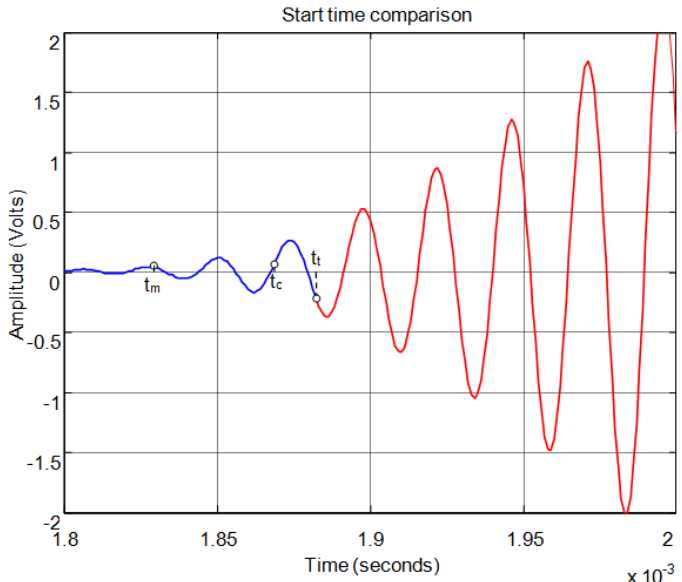
, auto-correlation t t